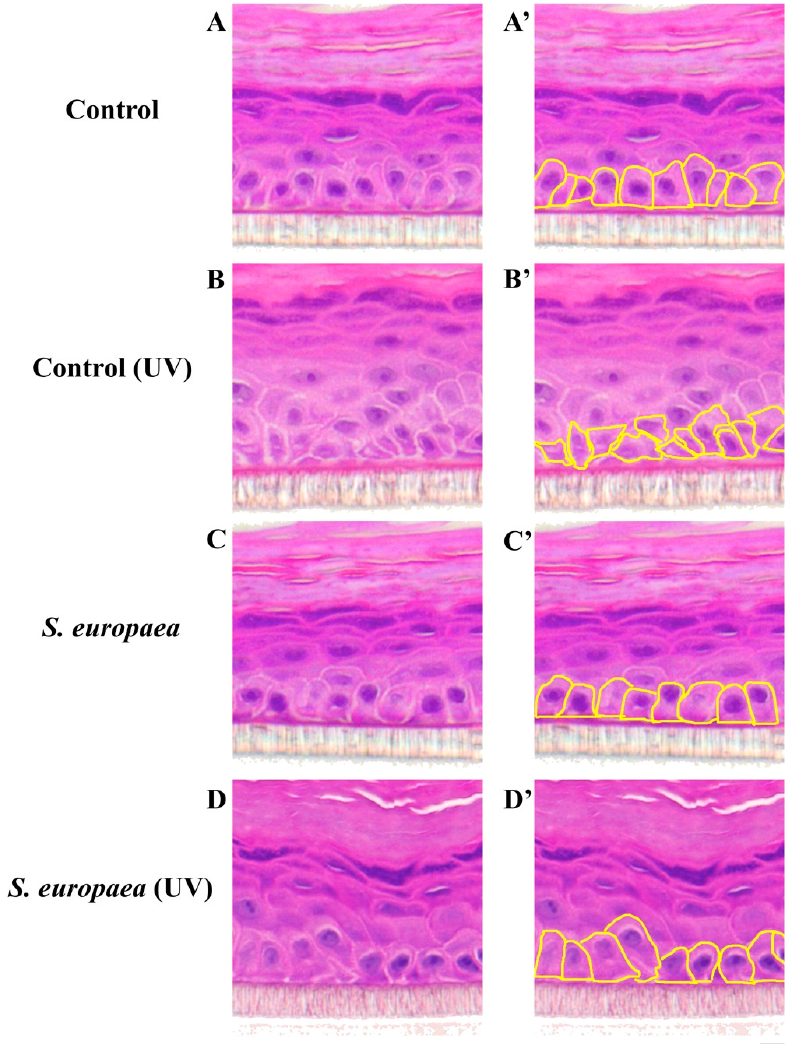
Figure 2. Improvements in the morphology and arrangement of UVB-exposed epidermal cells in the basal layer, after treatment with S. europaea . Light microscopic images of the cross section of hematoxylin-eosin-stained keratinocytes in a multilayered, highly differentiated in vitro skin model. ( A ) control keratinocytes; ( B ) UVB-exposed keratinocytes; ( C ) control keratinocytes after treatment with S. europaea ; and ( D ) UVB-exposed keratinocytes after treatment with S. europaea . Typical morphological features of suprabasal keratinocytes are demarcated with yellow lines ( A’ – D’ ). Scale bar, 10 µm.